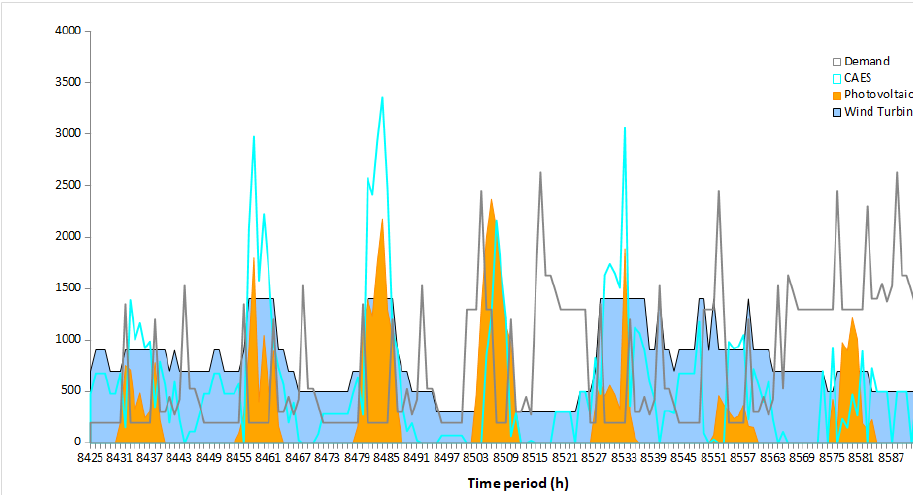
Figure 6. Energy produced by the system with micro-CAES during December.